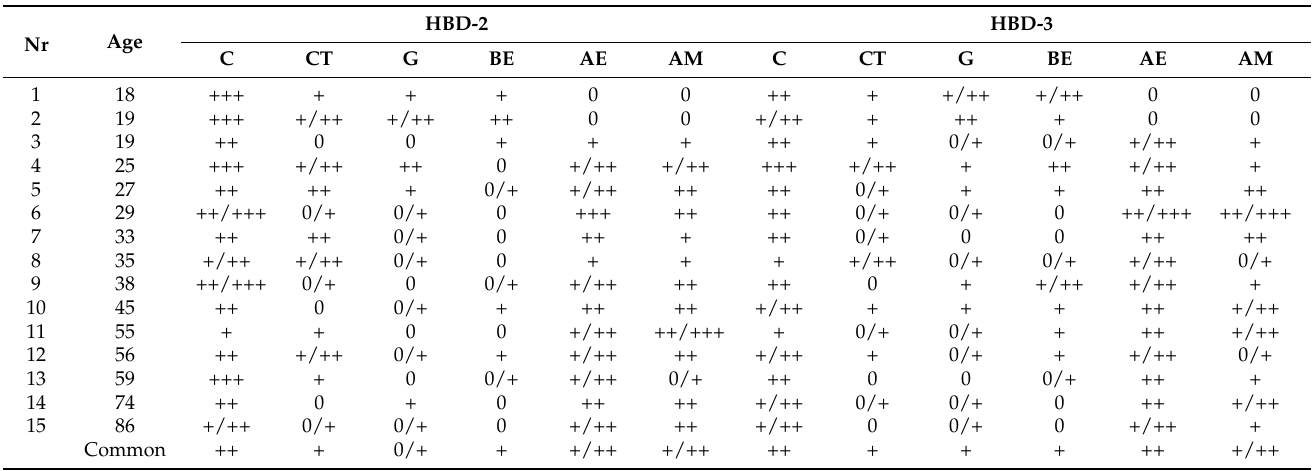
Table 1. Relative number of HBD-2 and HBD-3-positive structures in the healthy lung structures: cartilage, connective tissue, glands, bronchial epithelium, alveolar macrophages and alveolar epithelium.